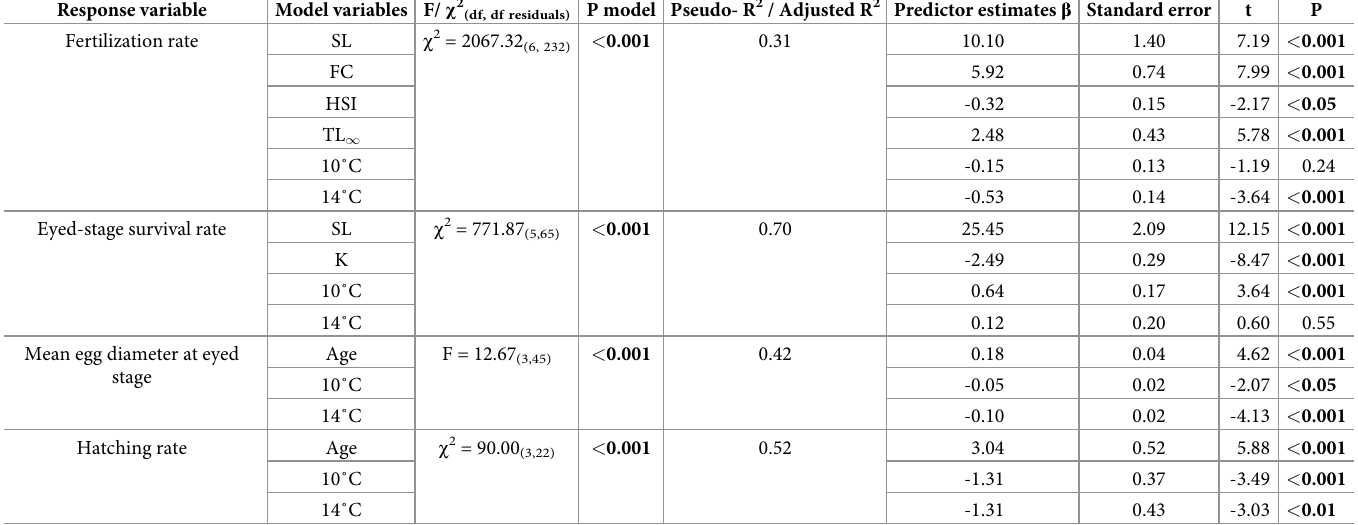
Table 4. Multiple regression results evaluating the relationships between embryonic traits and female trait predictors for Downs herring ( Clupea harengus ). SL: standard length; FC: Fulton condition index; HSI: Hepatosomatic index; TL 1 : Asymptotic average length; K: Brody growth rate coefficient; F: ANOVA F-test; χ 2 : Wald test; df: degrees of freedom; t: t-test; P: P-value. For temperature, which is qualitative, 8˚C is considered here as the comparison standard. P-values in bold are statistically significant (at α = 0.05). Response